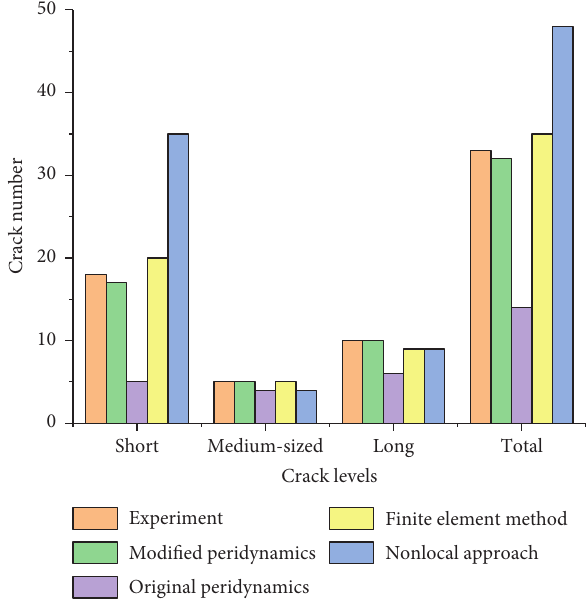
Figure 10: Crack number predicted by different methods ( T